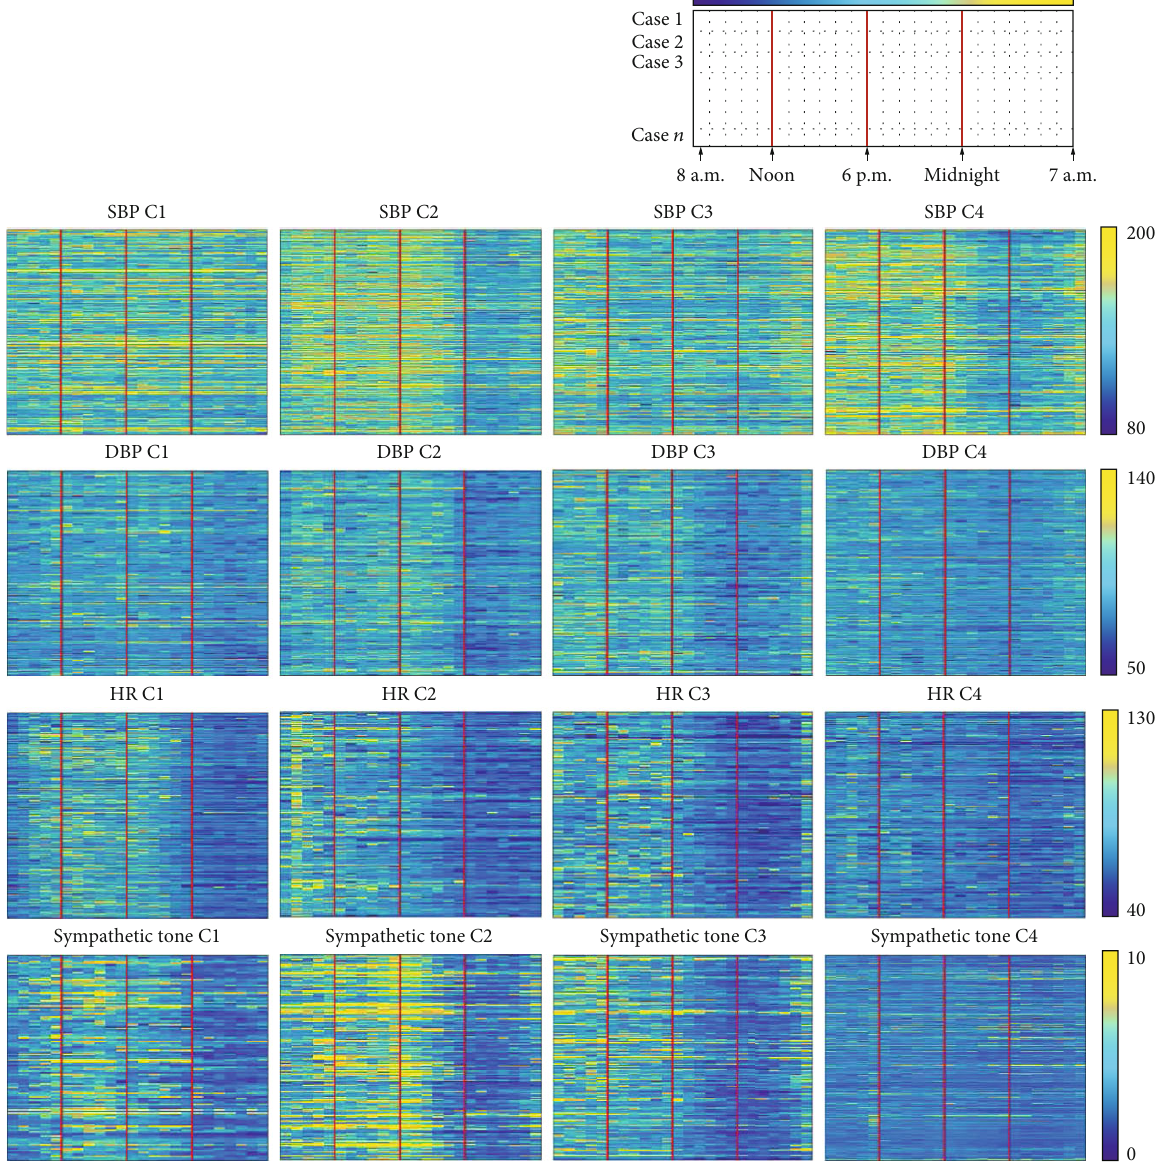
Figure 1: Time series clustering patterns of SBP, DBP, HR, and sympathetic tone. Each time series measurement is represented in matrix form ( 989 cases ½ row (cid:2) × 24 hourly measurements [column]) and visualized using a color map (blue denotes a low value, and yellow denotes a high value for each variable). The measurement time is arranged from left to right in the sequence of morning, afternoon, evening, night, and dawn. Time series patterns are observed to di ff er by